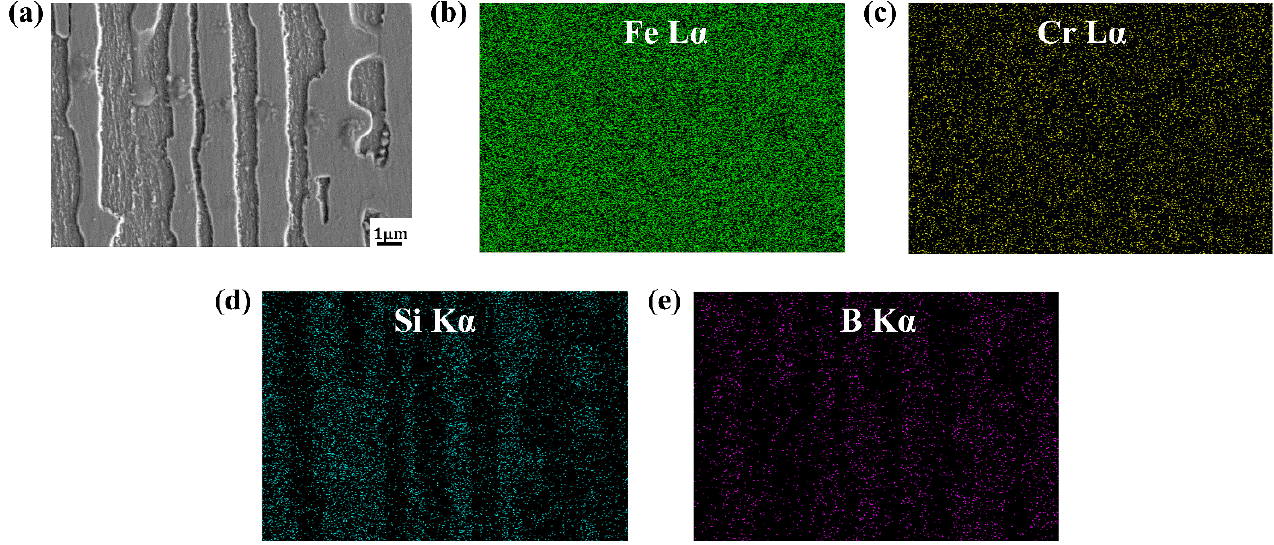
Figure 7. The EDS maps of A3 DS Fe-B alloy: ( a ) micrograph of surface scanning, ( b ) element dis- tribution of Fe, ( c ) element distribution of Cr, ( d ) element distribution of Si, ( e ) element distribu- tion of B.